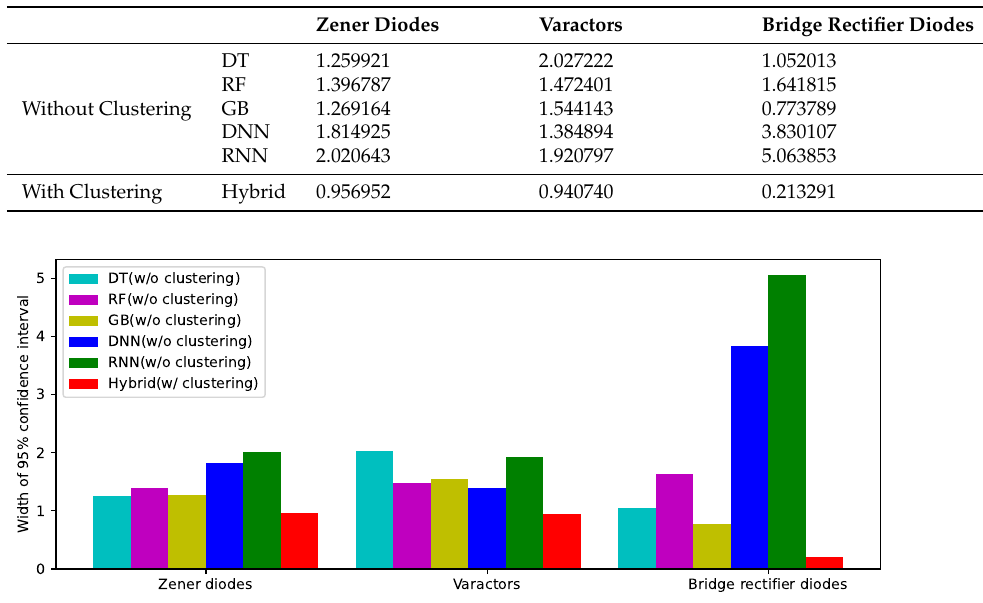
Figure 16. The widths of the 95% confidence intervals of the predicted values using various methods for the Zener diodes, varactors, and bridge rectifier